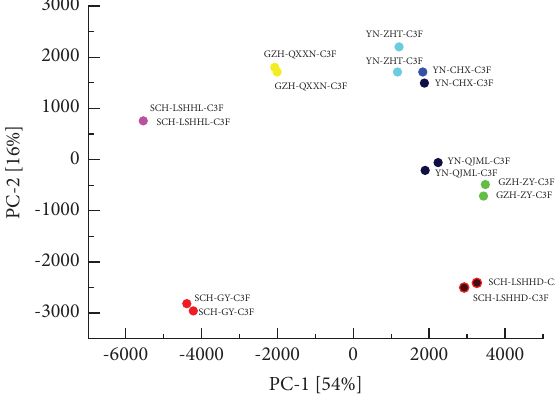
Figure 4: Te principal component analysis of each